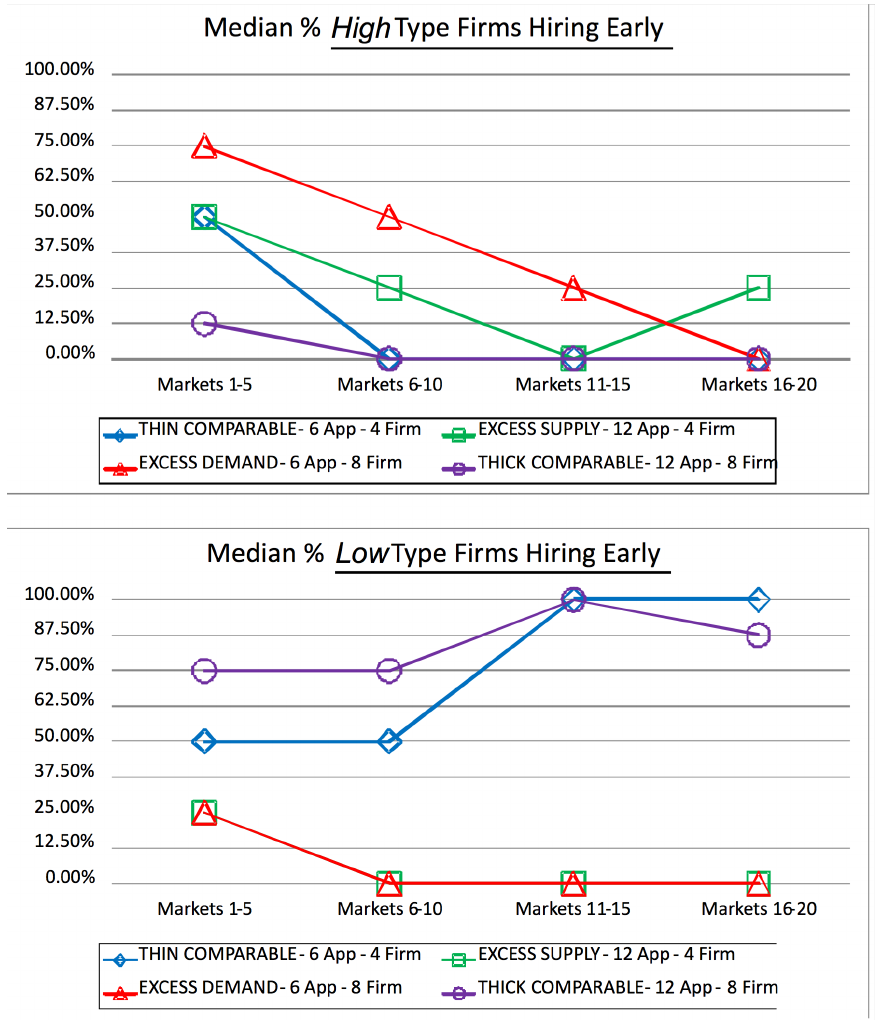
Figure 1. Median percentage of high and low type firms hiring early across